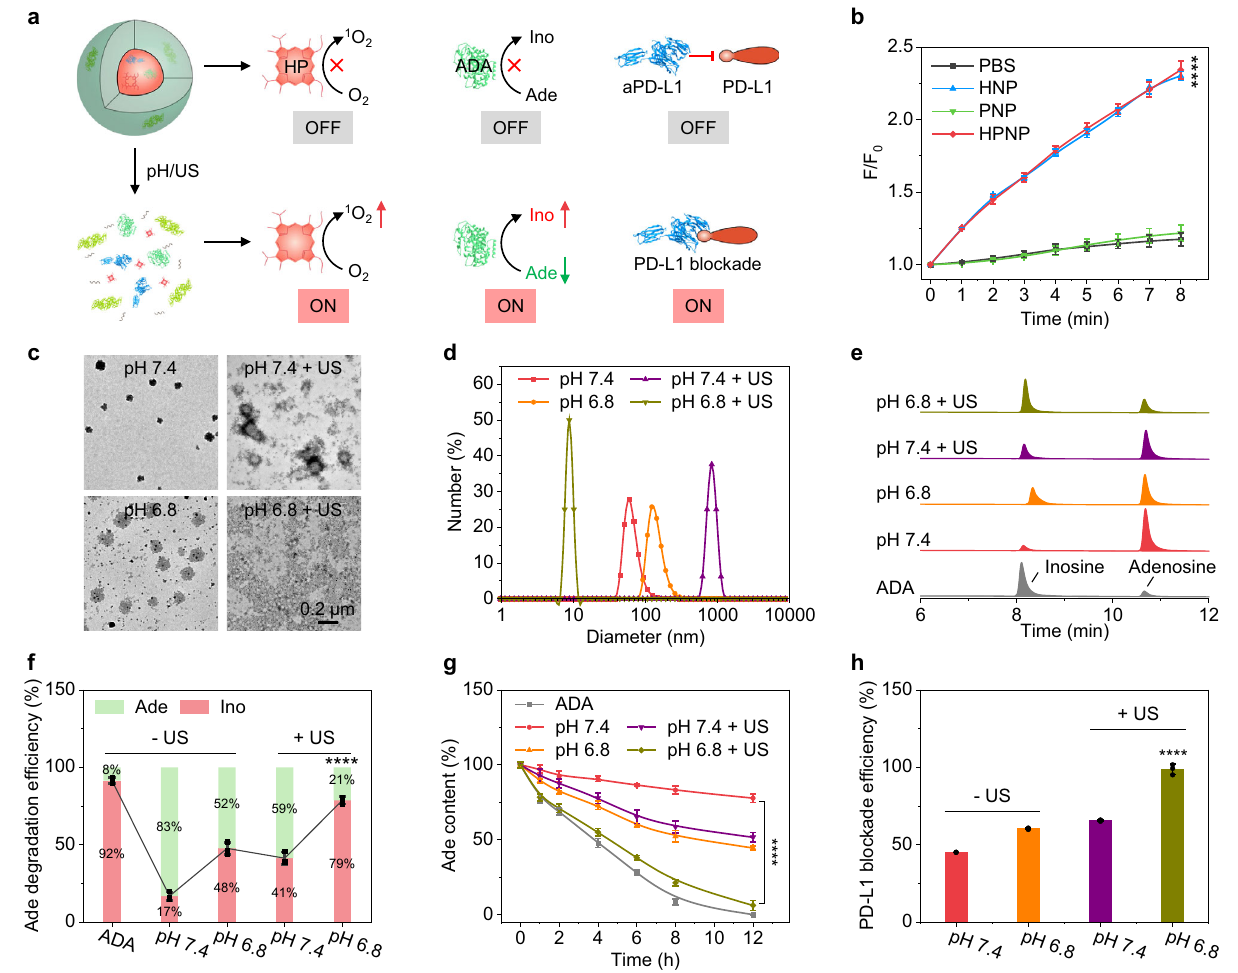
Fig. 2 In vitro evaluation of the acidic TME/sono-activation of the nano-immunocomplex. a Schematic mechanisms of the acidic TME/sono-activated disassociation of the nano-immunocomplex and the OFF-ON switches of sonodynamic 1 O 2 generation, ADA-induced Ade degradation, and aPD-L1- mediated PD-L1 blockade. b The generation of 1 O 2 in HNP, PNP, and HPNP in 1× PBS buffer (pH 7.4) ([HP] = 20 μ mol/L or [ADA] = 800 U/L) as a function of the sono-irradiation (1.0 MHz, 1.2 W/cm 2 , 50% duty cycle) time ( n = 3). HPNP versus PBS: p < 0.0001. c TEM images and d DLS pro fi les of HPNPs in different conditions (pH 7.4, pH 7.4 with sono-irradiation, pH 6.8, and pH 6.8 with sono-irradiation). The experiments were repeated independently three times with similar results. e HPLC pro fi les and f quanti fi cation of Ade and Ino after 8 h incubation of HPNPs ([ADA] = 40 U/L) in PBS solutions containing Ade (20 mmol/L) with different treatments (pH 7.4, pH 7.4 with sono-irradiation, pH 6.8, and pH 6.8 with sono-irradiation) ( n = 3). pH 6.8 with sono-irradiation versus pH 7.4: p < 0.0001. g Ade degradation pro fi les of HPNPs in the presence of Ade at different conditions (pH 7.4, pH 7.4 with sono-irradiation, pH 6.8, and pH 6.8 with sono-irradiation) ( n = 3). pH 6.8 with sono-irradiation versus pH 7.4: p < 0.0001. h PD-L1 blockade ef fi ciency after 12 h incubation of HPNPs at different conditions (pH 7.4, pH 7.4 with sono-irradiation, pH 6.8, and pH 6.8 with sono-irradiation) ( n = 3). pH 6.8 with sono-irradiatio n versus pH 7.4: p < 0.0001. Sono-irradiation: 1.0 MHz, 1.2 W/cm 2 , 50% duty cycle for 6 min. Statistical signi fi cance in b and g was calculated via a two-tailed Student ’ s t -test. Statistical signi fi cance in f and h was calculated via one-way ANOVA with a Tukey post-hoc test. **** p < 0.0001. The mean values and SD are presented. Source data are provided as a Source Data fi of Ade with ADA and the crosslinking-mediated shielding of the catalytic sites of ADA in the nano-immunocomplex. The Ade degradation pro fi les further validated the acidic TME/sono- activation of ADA (Fig. 2g, Supplementary Fig. 5). To further study the acidic TME/sono-activation of aPD-L1, the PD-L1 blockade ef fi ciency was detected by enzyme-linked immunosor- bent assay (ELISA). The ELISA results exhibited the highest PD- L1 blockade ef fi ciency (99%) after incubation of HPNP in pH 6.8 solutions and sono-irradiation (Fig. 2h). In contrast, the PD- L1 blockade ef fi ciency was only 45%, 60%, or 66% after incubation of HPNP in the conditions of pH 7.4, pH 6.8, or pH 7.4 with sono-irradiation. This is due to the incomplete disassociation of HPNP and partial release of aPD-L1 in the conditions of pH 7.4, pH 6.8, or pH 7.4 with sono-irradiation.